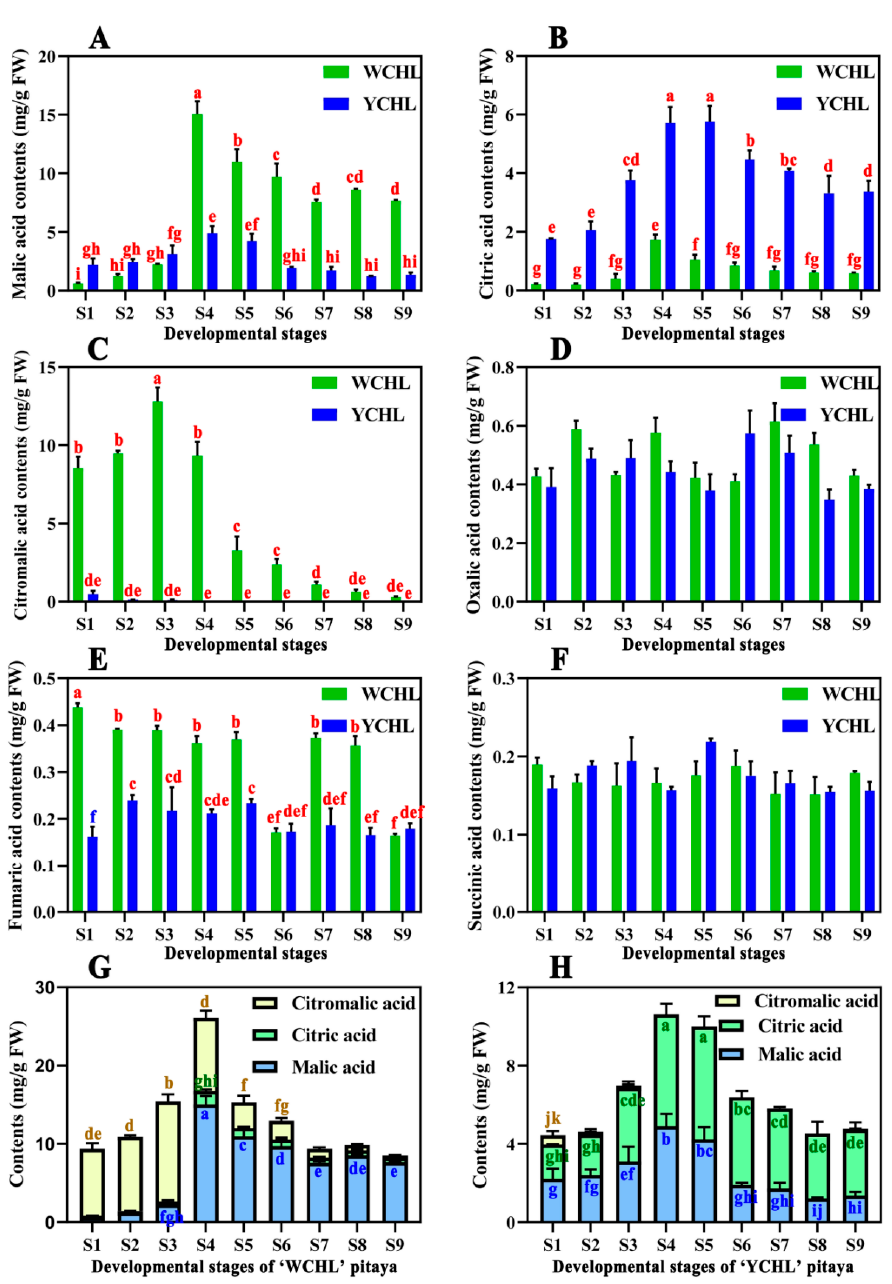
Figure 4. Changes in organic acid contents in pulps during fruit developmental stages of ‘WCHL’